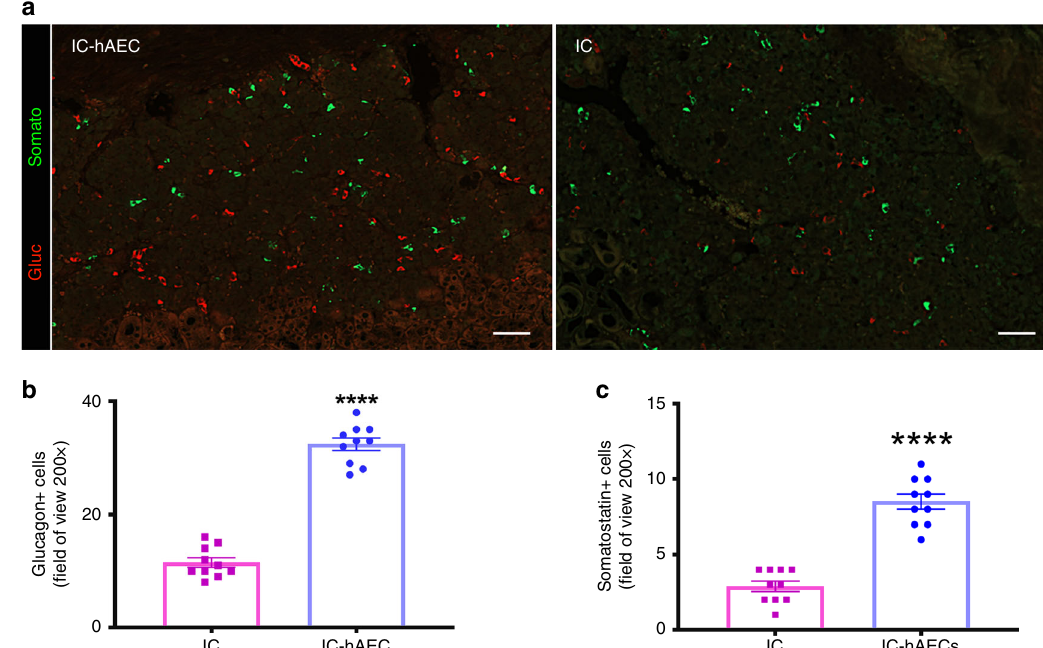
Fig. 5 Immunohistochemical analysis of hormone production in the grafts. a – c Glucagon and somatostatin-positive cells quanti fi ed in each group in the fi eld of view (magni fi cation ×200), scale bars 50 μ m. **** p < 0.0001 vs IC group, unpaired Student ’ s t test, n = 10, data are mean ±